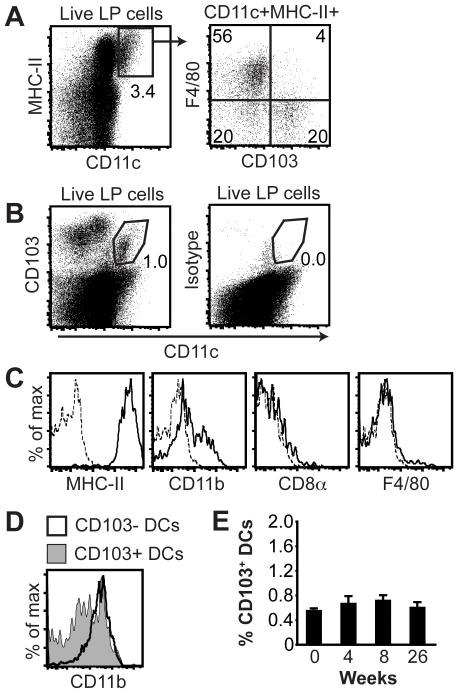
Identification of gastric lamina propria DCs.(A) Flow cytometric analyses of CD11c+MHC-II+ cells in the gastric lamina propria of individual mice revealed two F4/80− DC populations with differential expression of CD103 (lower quadrants in the F4/80 versus CD103 dot plot). (B) Expression of CD103 and CD11c by gastric lamina propria cells. The gate for CD103+ DCs is indicated. Isotype, isotype-matched control antibody for CD103. (C) Expression of MHC-II, CD8α, F4/80 and CD11b by gated CD11c+CD103+ cells. Dotted lines show staining with isotype controls. (D) Expression of CD11b by CD103− and CD103+ DCs. DCs were gated as described in A. (E) Frequency of CD103+ DCs in the gastric lamina propria at the indicated time points after H. pylori infection. Data represents means ± SEM of 7–15 individual mice. LP, lamina propria.